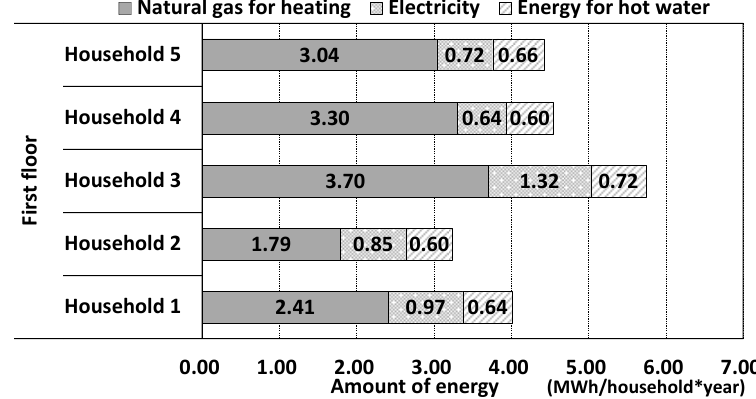
Figure 8. Yearly energy consumption of each household in the first floor.